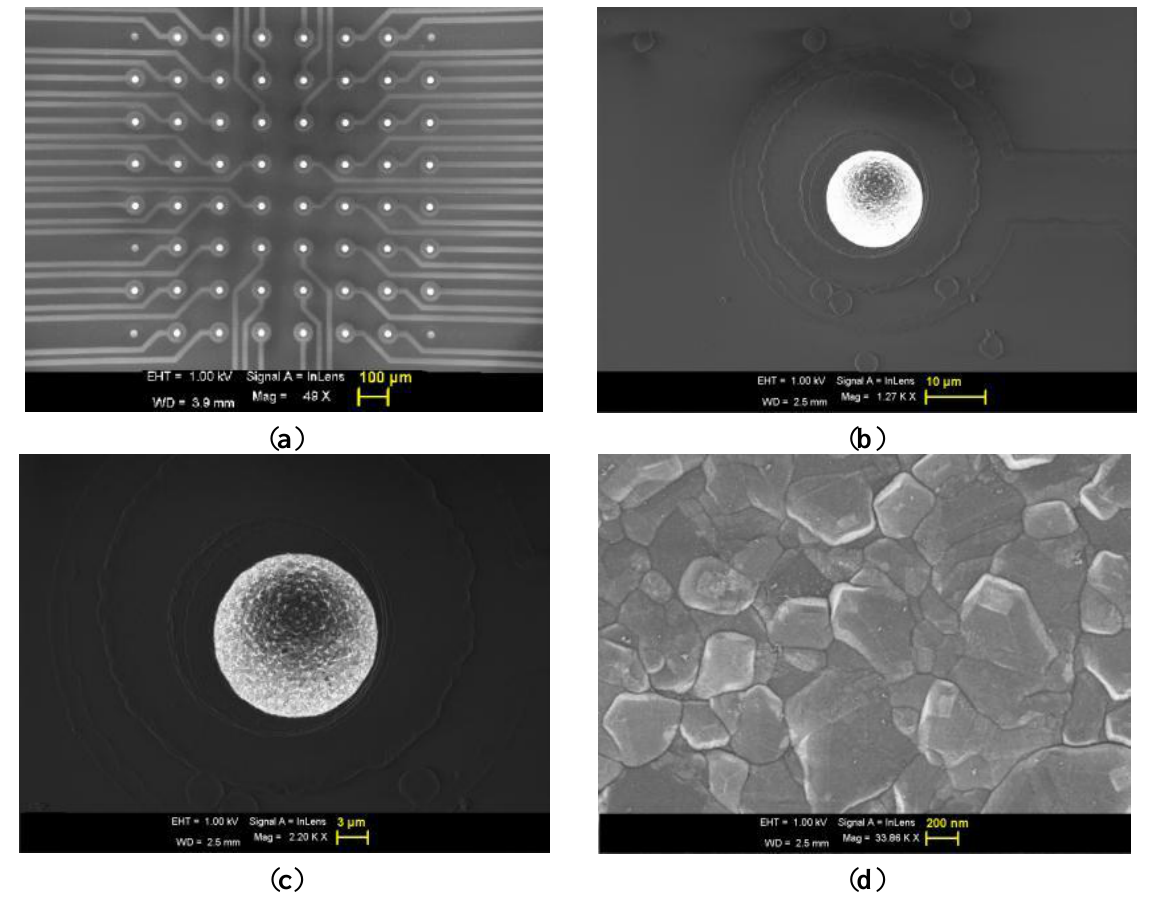
Figure 2. SEM image of an 8 × 8 UMEA along with the tracks ( a ) and magnified SEM image of a single electrode ( b , c and d